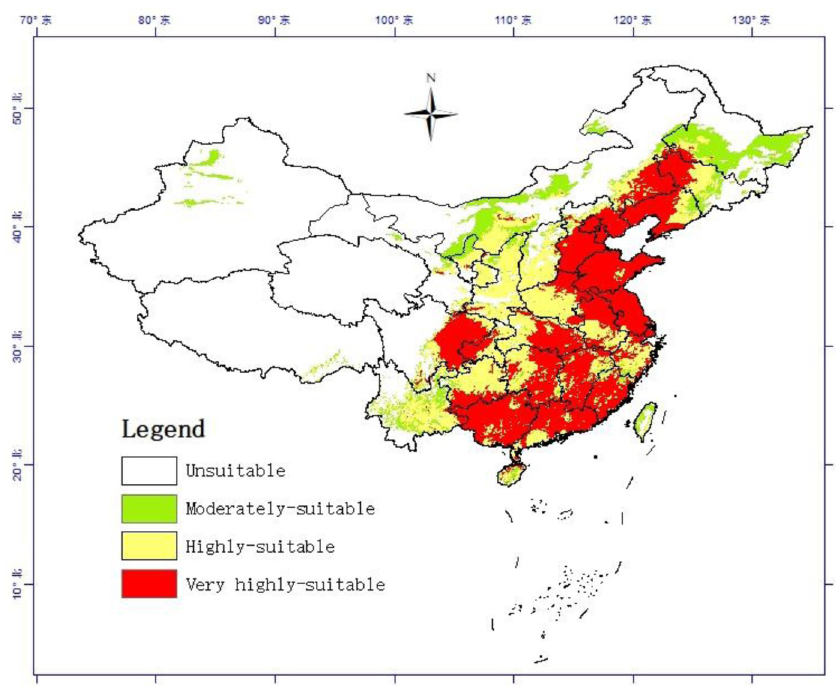
Fig 1. Potentially suitable climatic distribution of Pennisetum alopecuroides (L.) under current climate condition in China. The probability of Pennisetum alopecuroides (L.) is shown by the color scale in the area. Red indicates a very high suitable area with a probability of higher than 0.56, yellow indicates a highly suitable area with a probability of 0.35–0.56, green indicates a low suitable area with a probability ranging from 0.16 to 0.35, and white represents unsuitable areas. (For interpretation of the references to color in this figure legend, the reader is referred to the Web version of this article.).